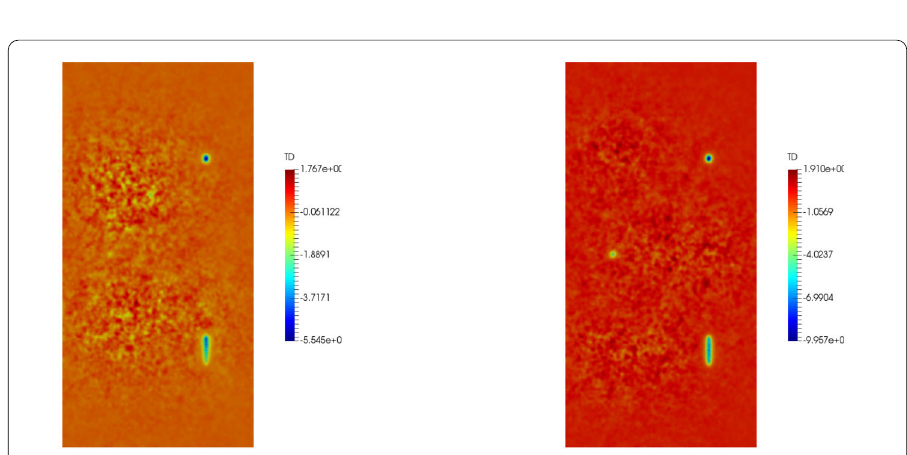
Figure 12 Topological derivative on Γ front combining three different lamp locations. Left: lamps linearly spaced along the z axis at a frequency of 2 Hz. Right: counterpart at 0.2 Hz. Combining different lamp locations is a great way to improve the reconstruction of several defects at the same time, but we still have to choose the adequate frequency